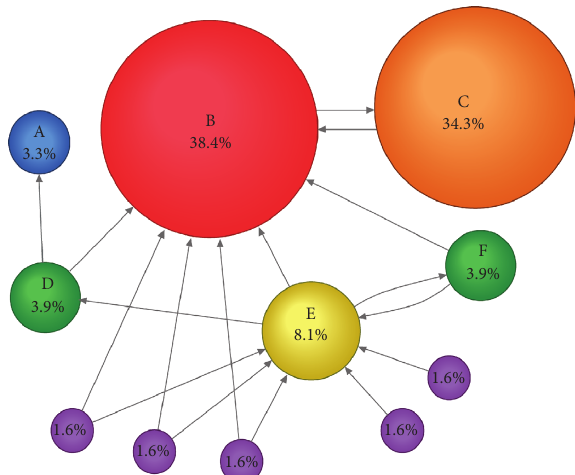
Figure 5: Schematic of eigenvector centrality of node. Note . The figure of percentage in the circle represents relative importance of the